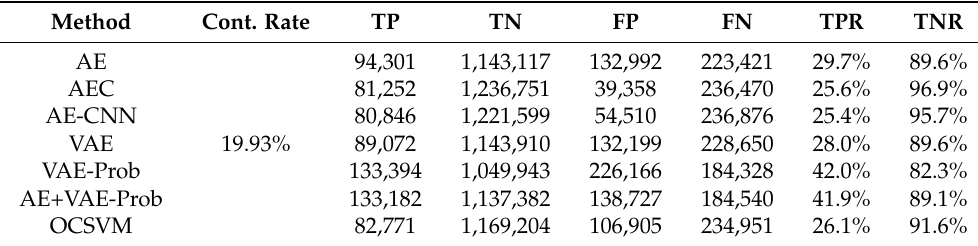
Table 7. Resulting confusion matrix for the detection of anomalies in the zero-day-attacks test dataset.